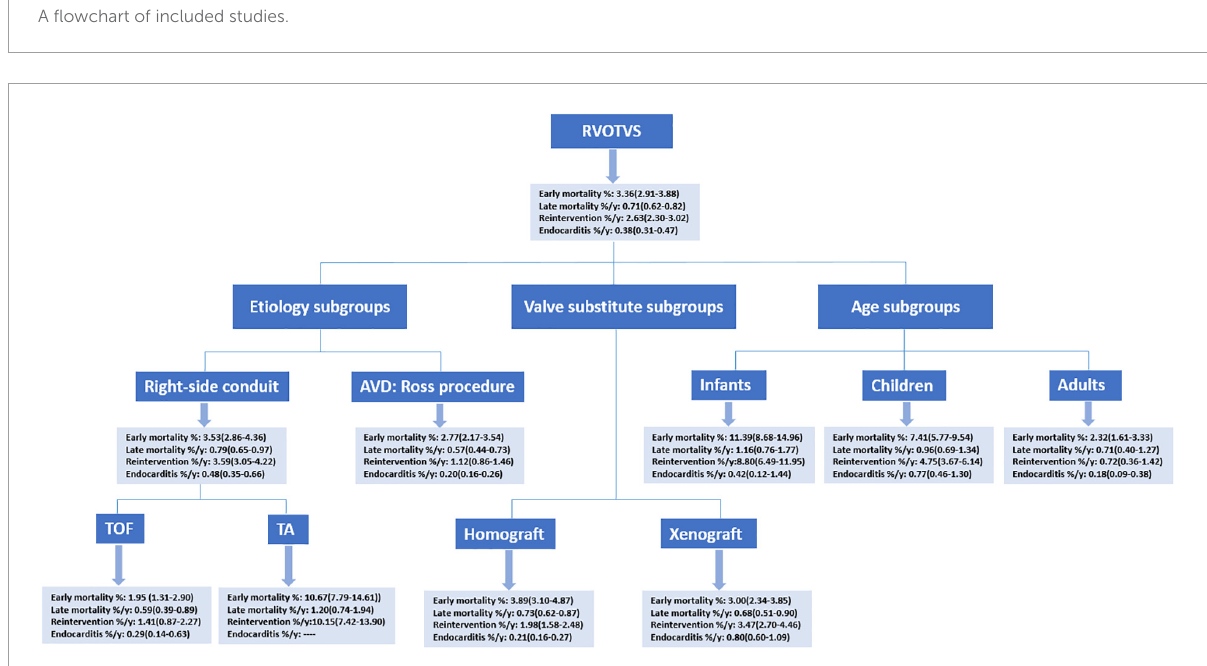
FIGURE2 A summary of pooled estimates. RVOTVS, right ventricular outflow tract reconstruction with valve substitutes.